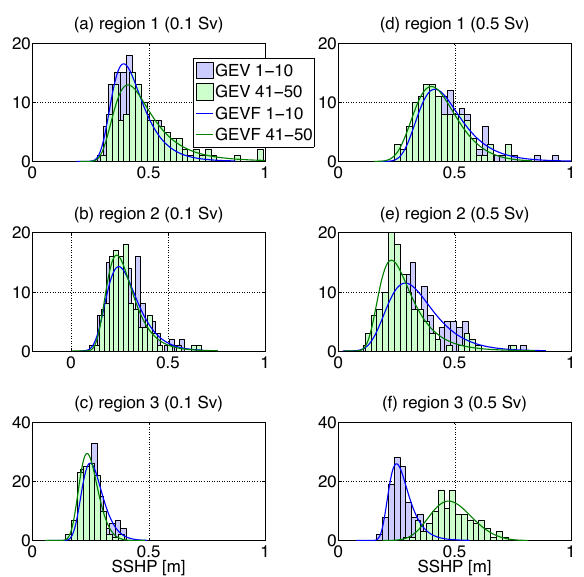
Figure 6. Generalised extreme-value (GEV) distribution and the Fig.6. Generalizedextremevalue(GEV)distributionandthecorrespondingfitteddistributionsofthemaximum corresponding fitted distributions of the maximum SSHP changes SSHP changes in the the regions shown in Fig. 5. (a-c) GEV plots for the 0.1 Sv HR simulation. (d-f) GEV in the the regions shown in Fig. 5. (a–c) GEV plots for the 0.1Sv plotsforthe0.5SvHRsimulation. HR simulation. (d–f) GEV plots for the 0.5Sv HR simulation.